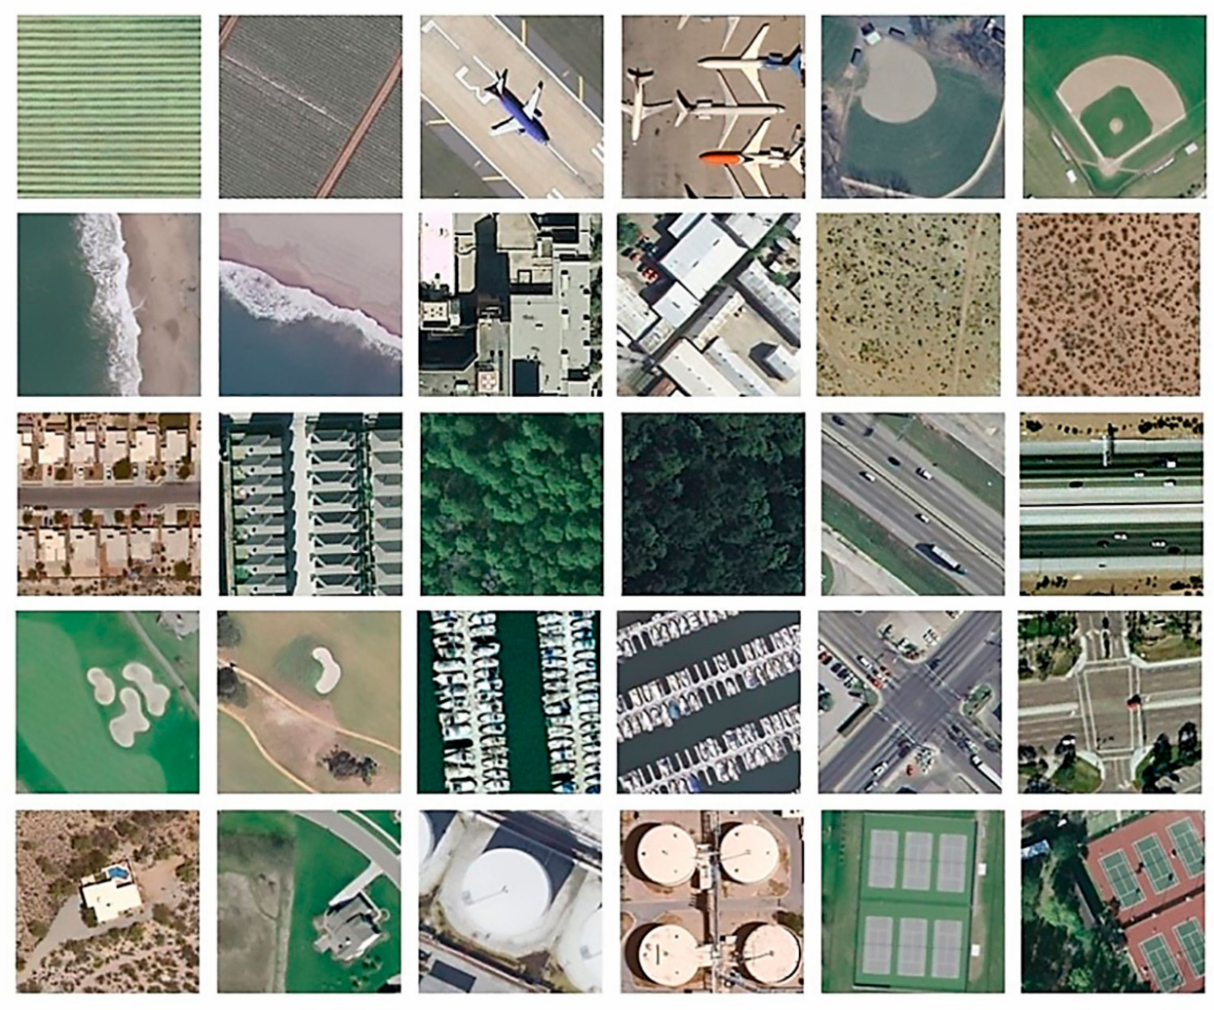
Figure 3. Samples-UCM